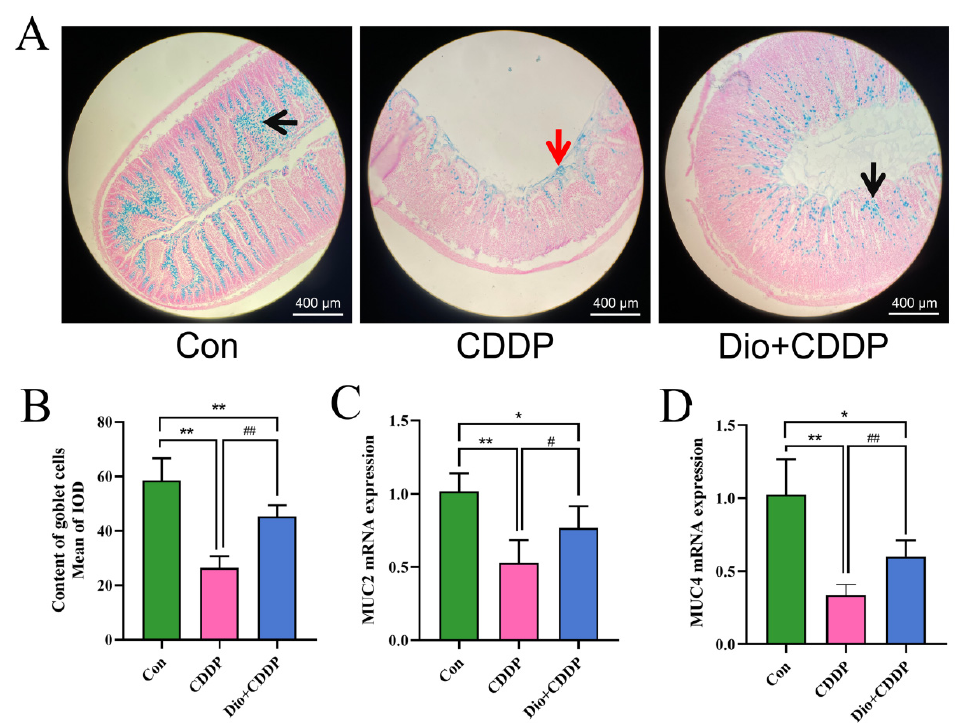
Figure 3. Dio administration promoted the expression of mucins and enhanced the quantity of gob- let cells in ileum. AB- Nuclear fast red staining of small intestine sections in the 3 groups of rats ( A ), black arrows indicate the mucin glycoproteins in goblet cells, red arrows indicate mucus spillage. Quantitative analysis of goblet cell in intestinal tissue ( B ). Effect of Dio on the mRNA levels of MUC2( C ) and MUC4 ( D ). All values were expressed as Mean ± S.D. (n = 6 samples per group). * p < 0.05, ** p < 0.01 vs. control group, # p < 0.05, ## p < 0.01 vs. CDDP group. 2.4. Dio Protected the Mucosal Barrier and Reduces Bacterial Translocation by Modulating TJs